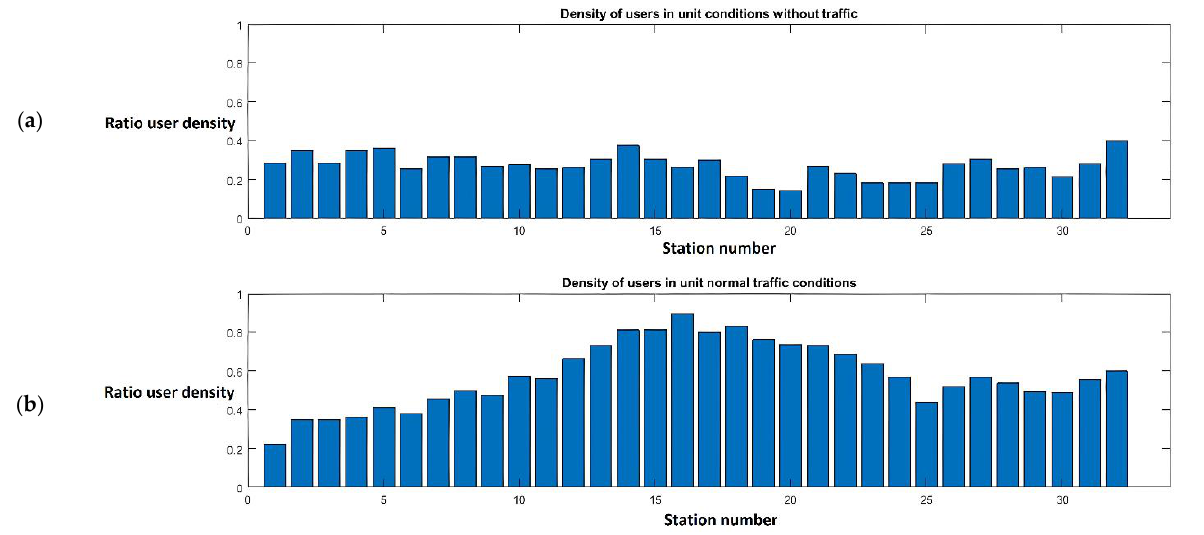
Figure 12. Density of users in a station: ( a ) without traffic conditions, ( b ) normal traffic conditions, and ( c ) with traffic conditions. See Table 3.